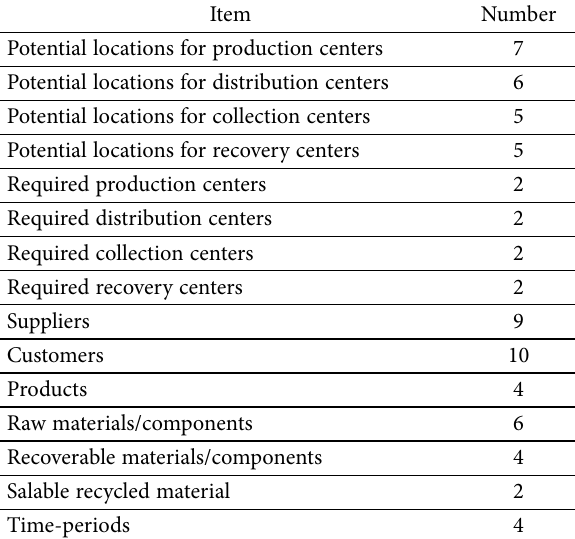
Table 4. Basic data of the